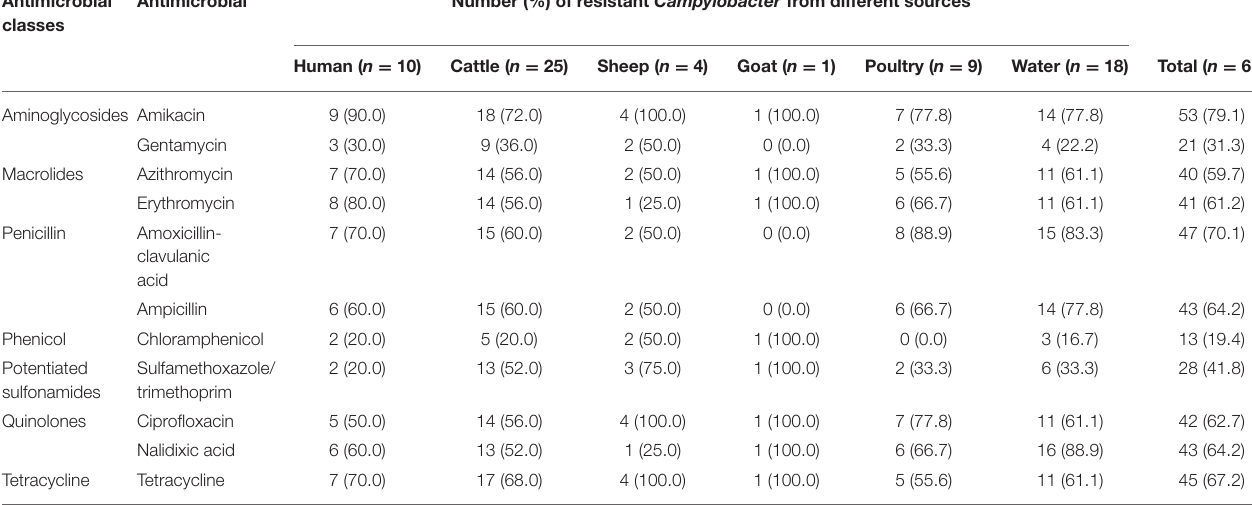
TABLE 5 | Antimicrobial susceptibility profiles of Campylobacter species isolated from various sources. Antimicrobial classes